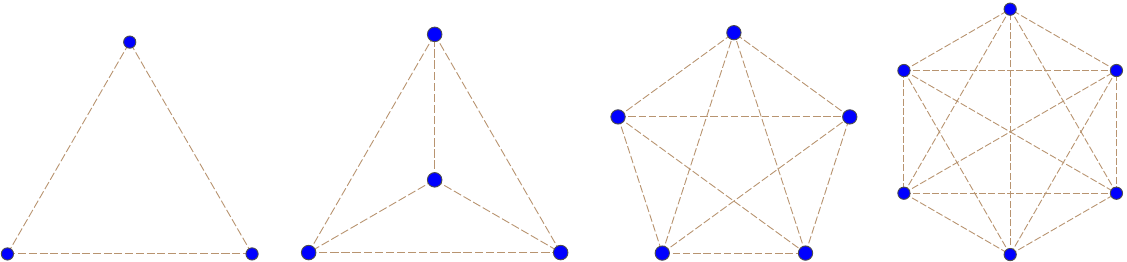
Figure 1. Examples with linear dominance. The individuals of the population are distributed over d colonies. From left to right: d = 3 ; d = 4 ; d = 5 ; d = 6 . Colonies are represented by full circles. Interactions and migration are possible between colonies connected by dashed edges. The interaction and migration graphs are both complete